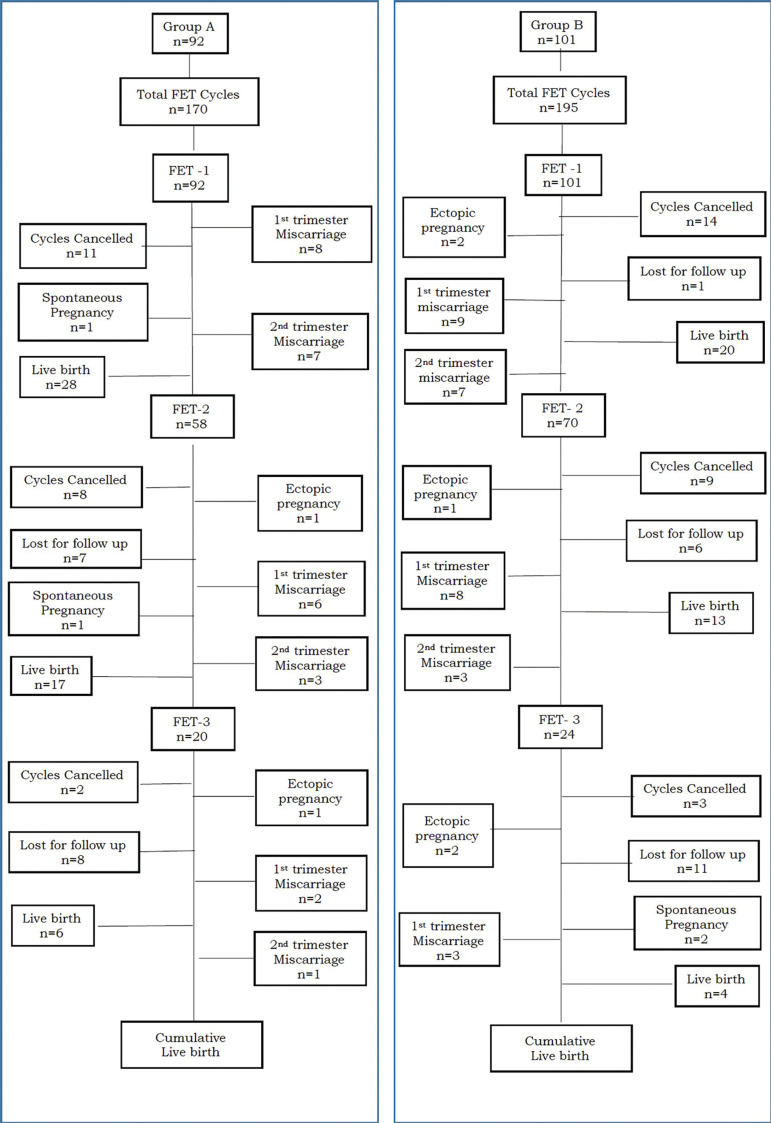
Subject flow chart